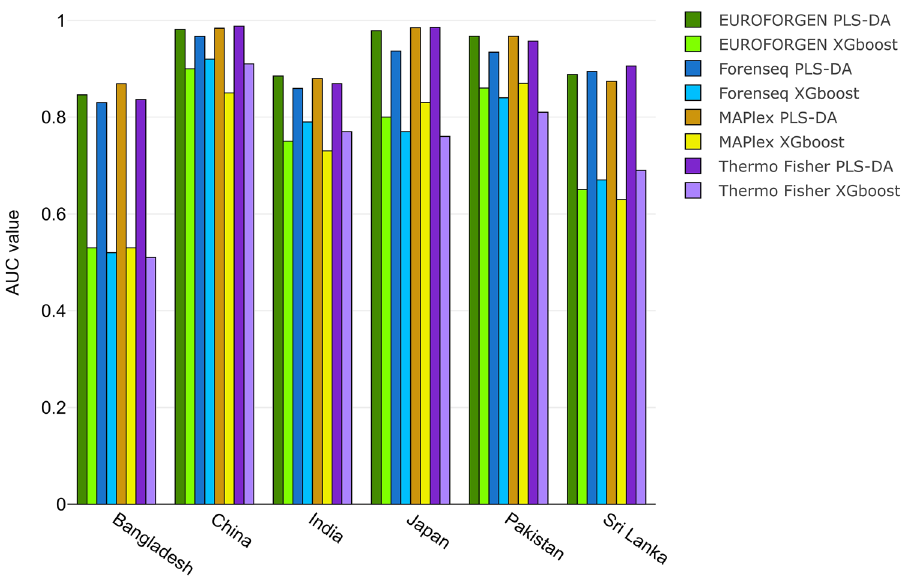
Figure 12. Comparison of AUC values obtained from PLS-DA and XGBoost model for Asian